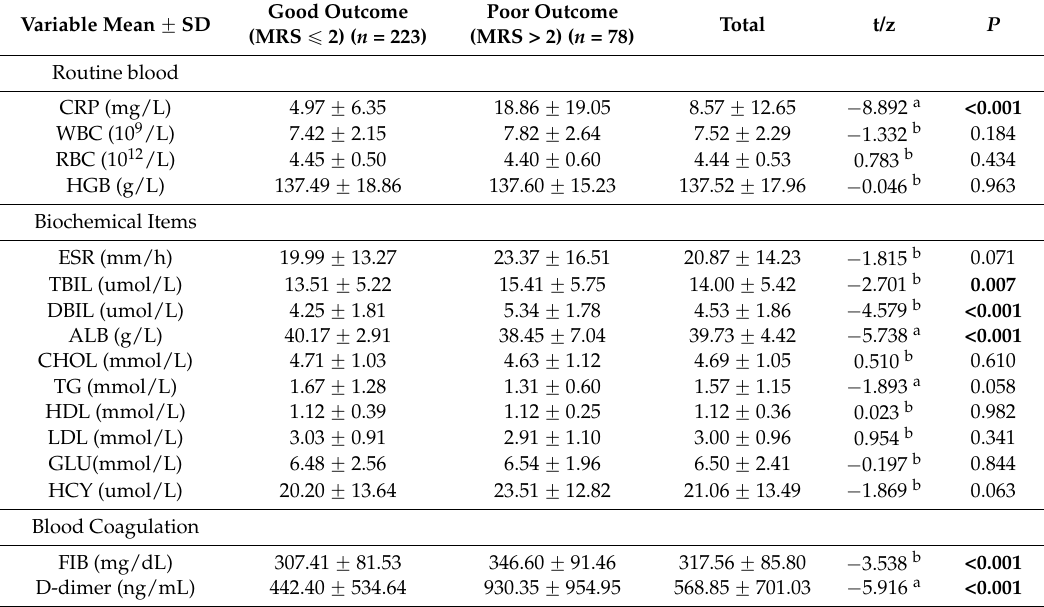
Table 3. Characteristics of clinical blood biochemical indexes linked to outcome at discharge in acute ischemic stroke